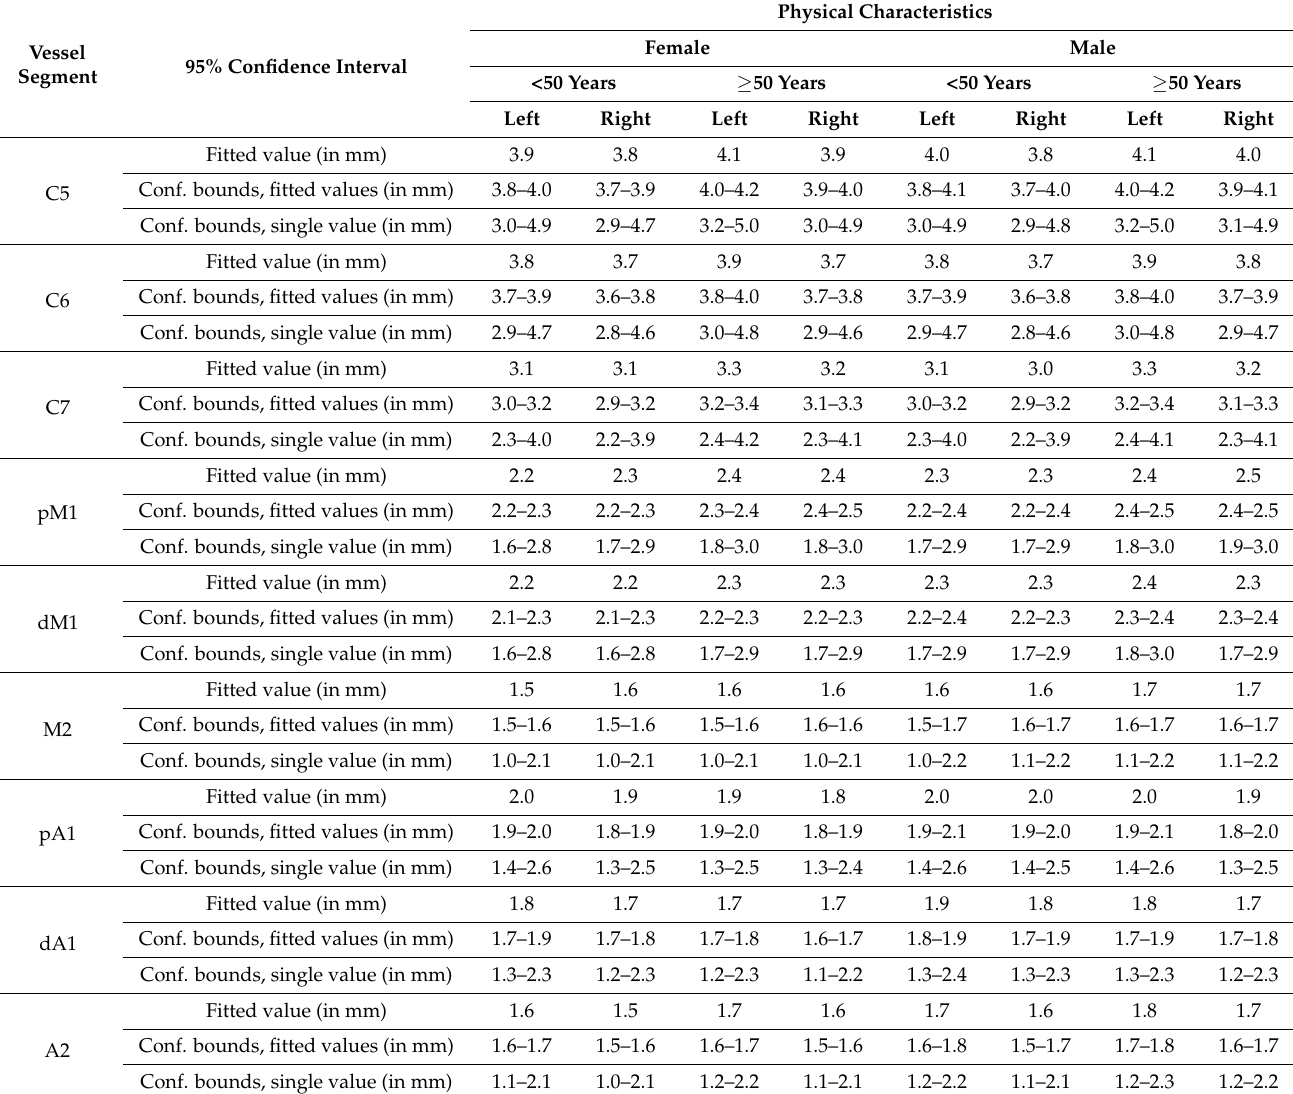
Table 3. Age-, gender-, and cranial side-adjusted reference values.